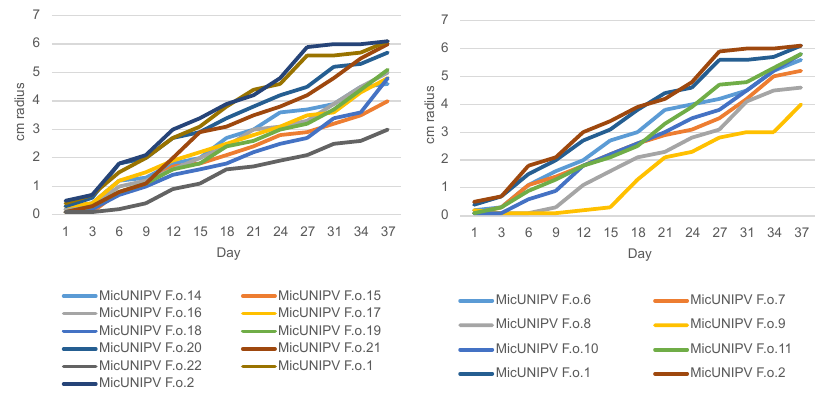
Figure 10 Growth curves of strains from Alpe Veglia (le) and Alpe Devero (right) on MEA.